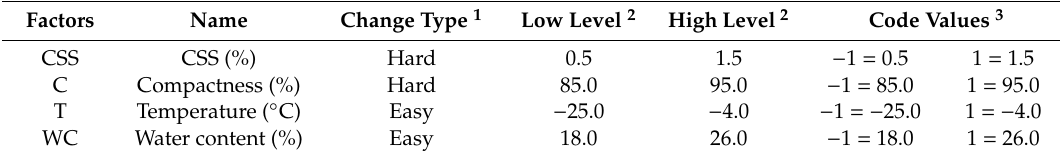
Table 2. Design summary of improved frost heave experiments.